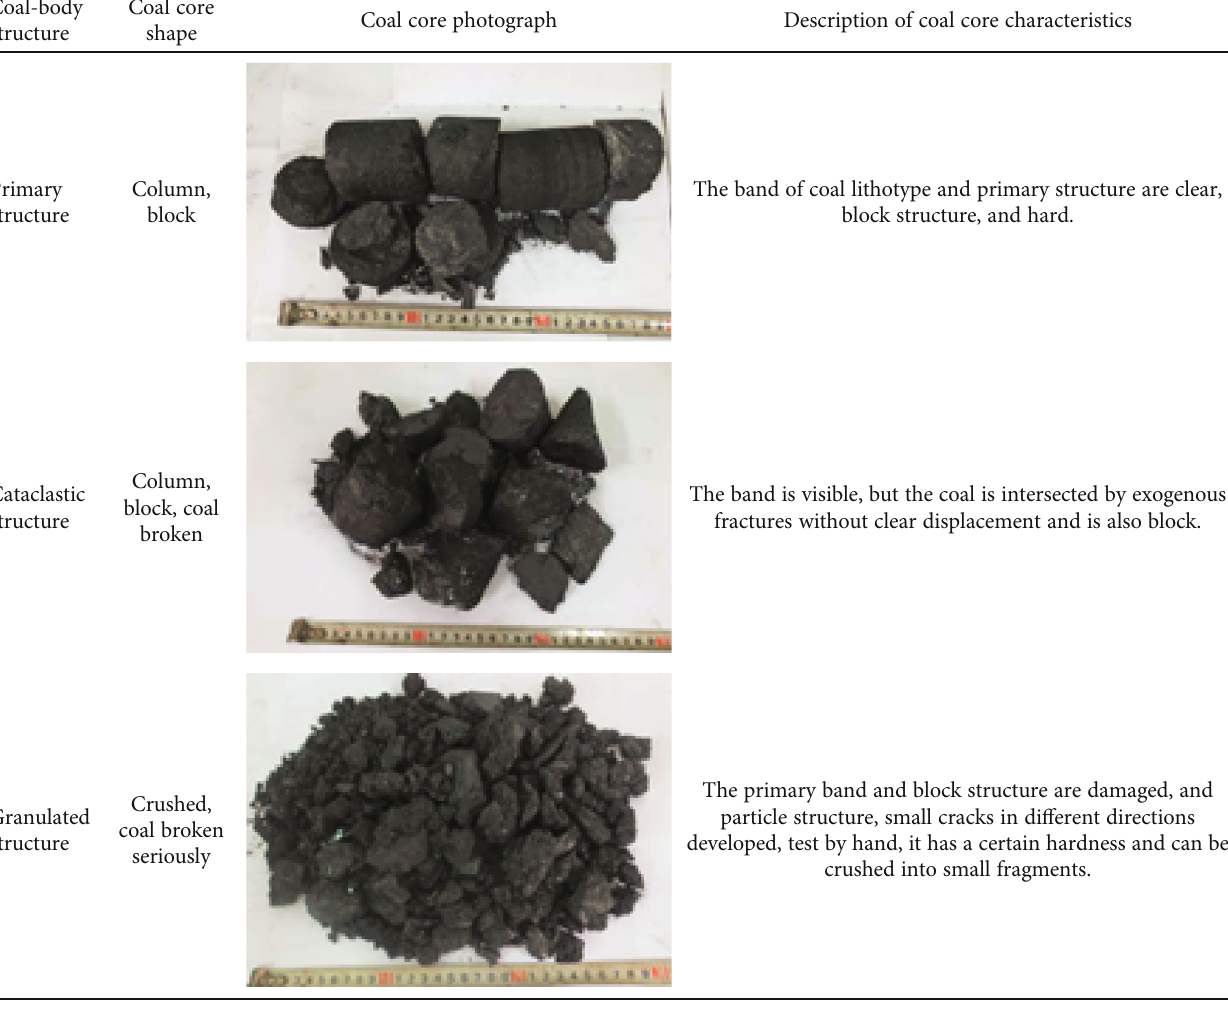
The band of coal lithotype and primary structure are clear, block structure, and hard.